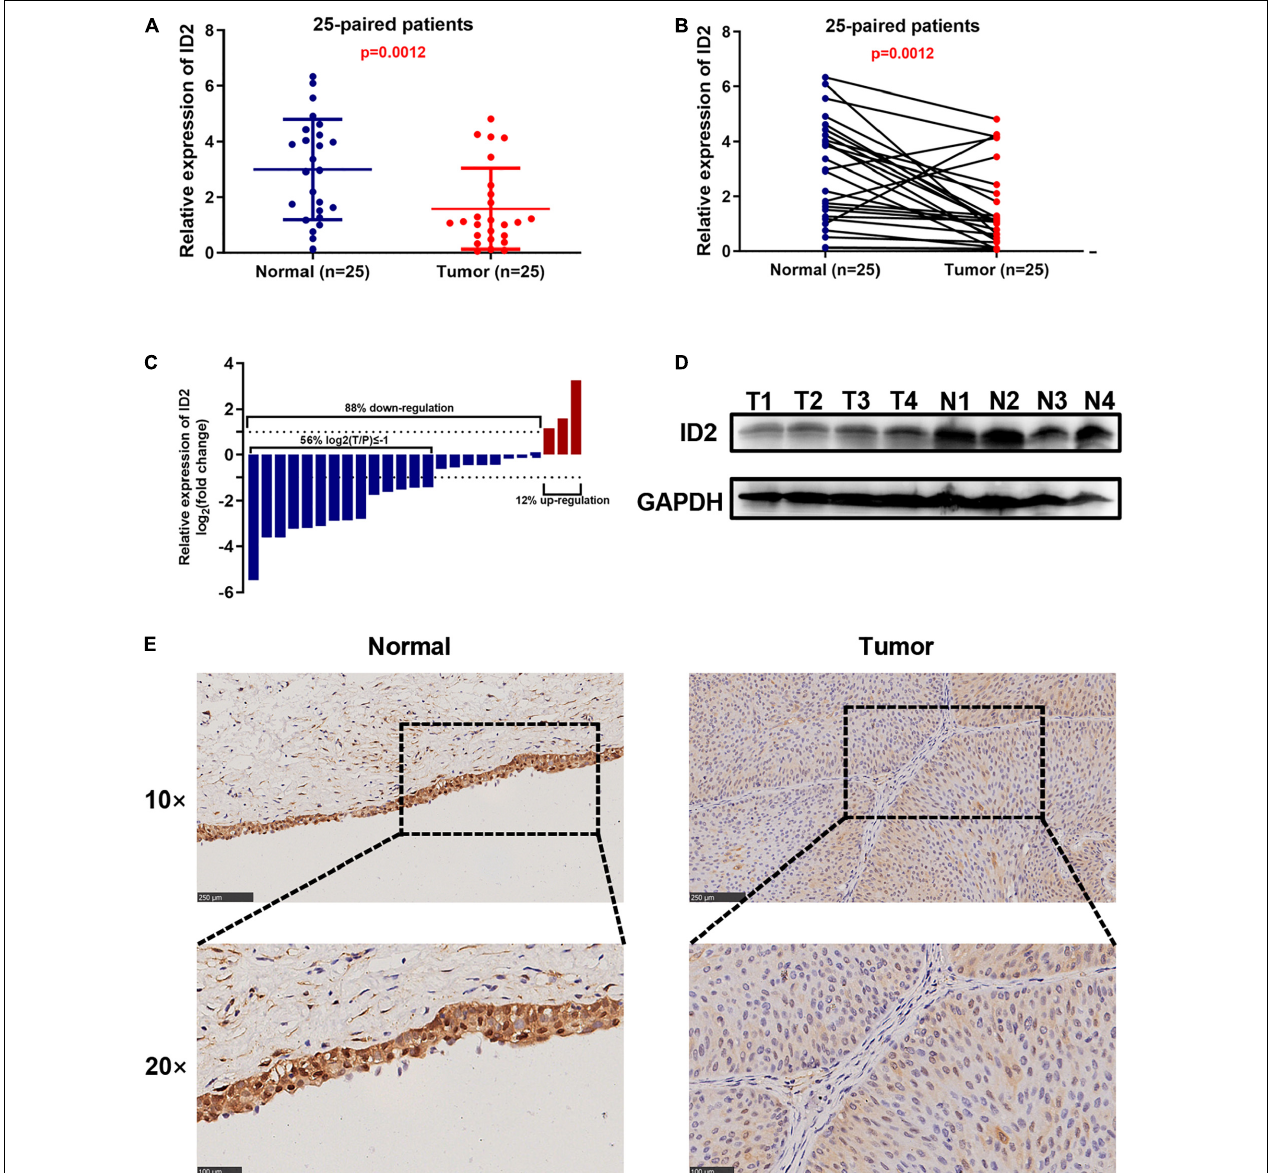
FIGURE 2 | ID2 is down-regulated in BCa clinical sample. (A–D) qRT-PCR (A–C) and western blot (D) analysis of ID2 expression levels in BCa tissues and paired normal tissues. (E) Representative IHC images showing ID2 staining in normal tissues (N) and BCa tumor (T) sections.